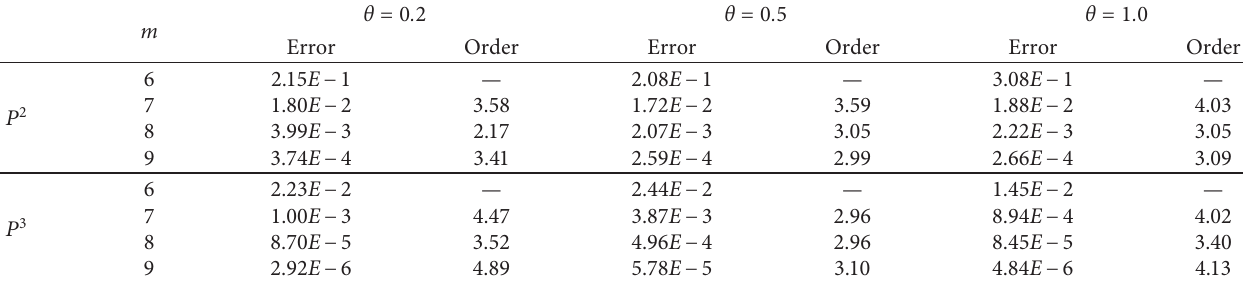
h for Example 1.